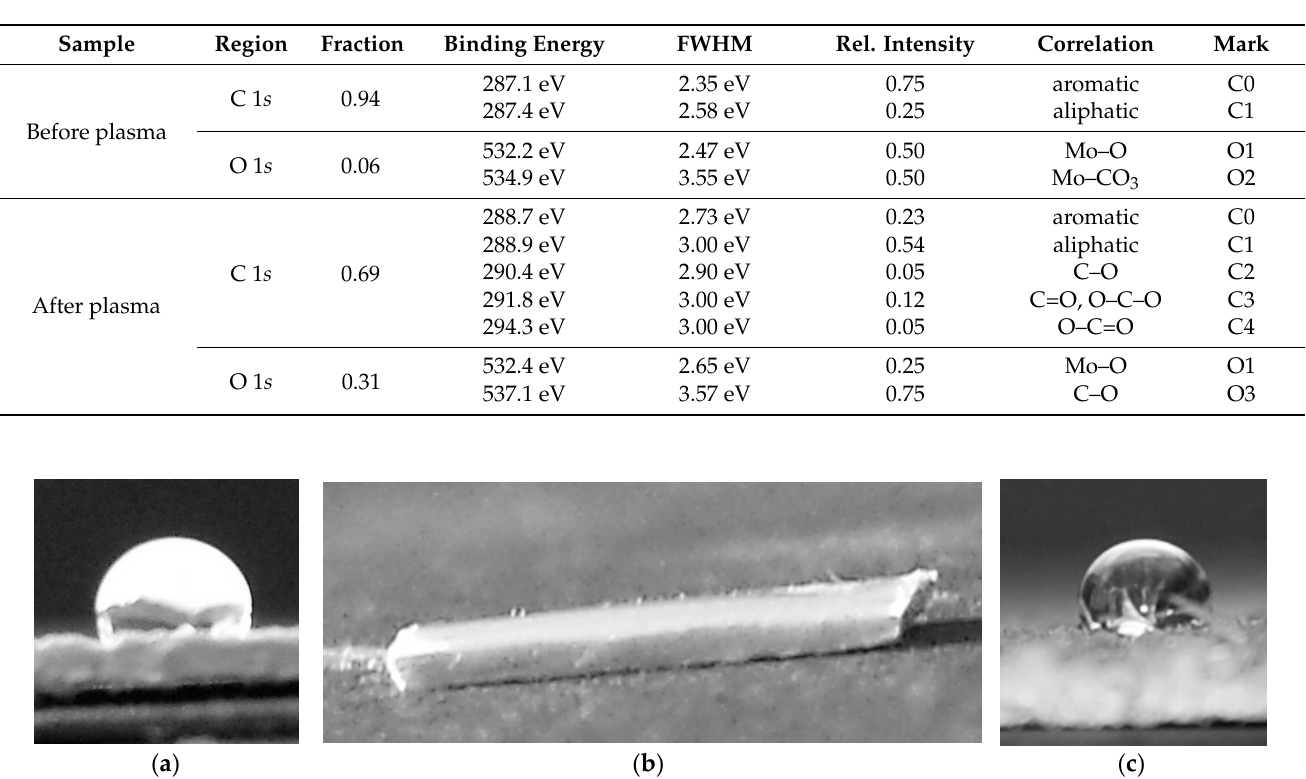
Table 2. Summarized XPS results.